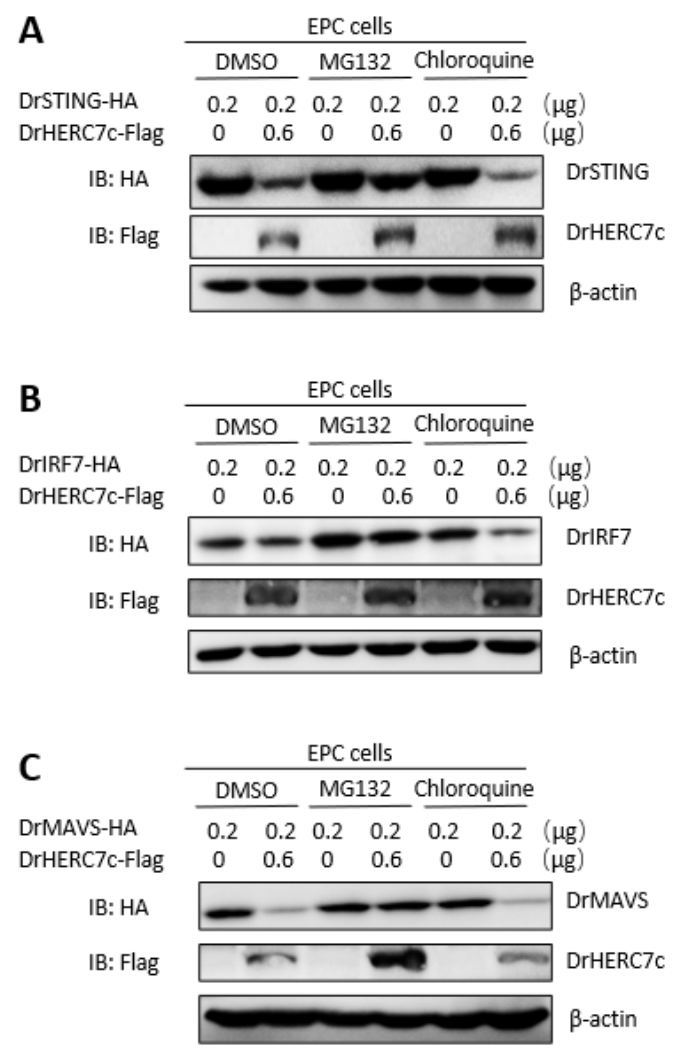
Figure 7. Zebrafish HERC7c-mediated degradation of STING, MAVS, and IRF7 was blocked by MG132 but not by chloroquine. EPC cells seeded in a 12-well plate were cotransfected with DrHERC7c-Flag and DrSTING-HA ( A ), DrMAVS-HA ( B ), or DrIRF7-HA ( C ), respectively. After 24 h, the cells were treated with MG132 (final concentration of 10 mM) and chloroquine (final concentration of 25 mM) for another 6 h, followed by Western blotting.